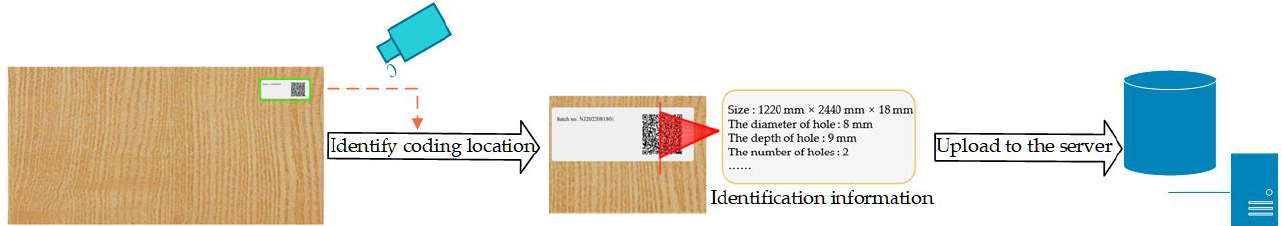
Figure 3. Flow chart of information collection.